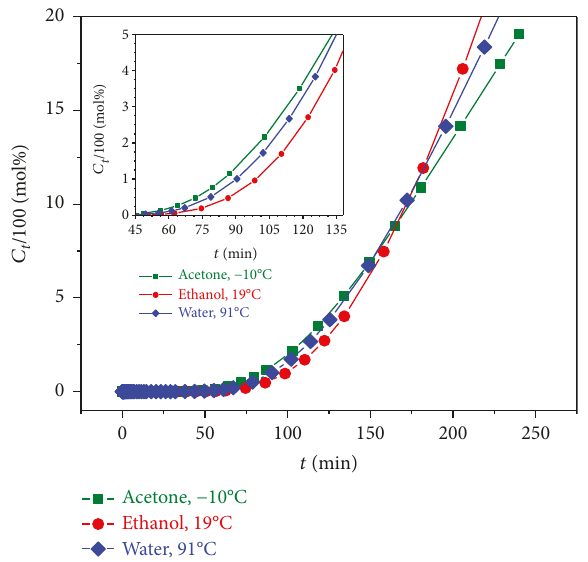
Figure 6: Simulation results of the temporal development of the concentration of acetone, ethanol, and water inside the rectangular sample (W × H × L: 2 × 10 × 50mm 3 ) at θ = − 10 , 19, and 91 ° C, respectively.